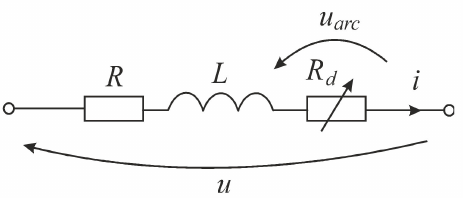
Figure 1. Circuit of an electric branch with inductance, active resistance and